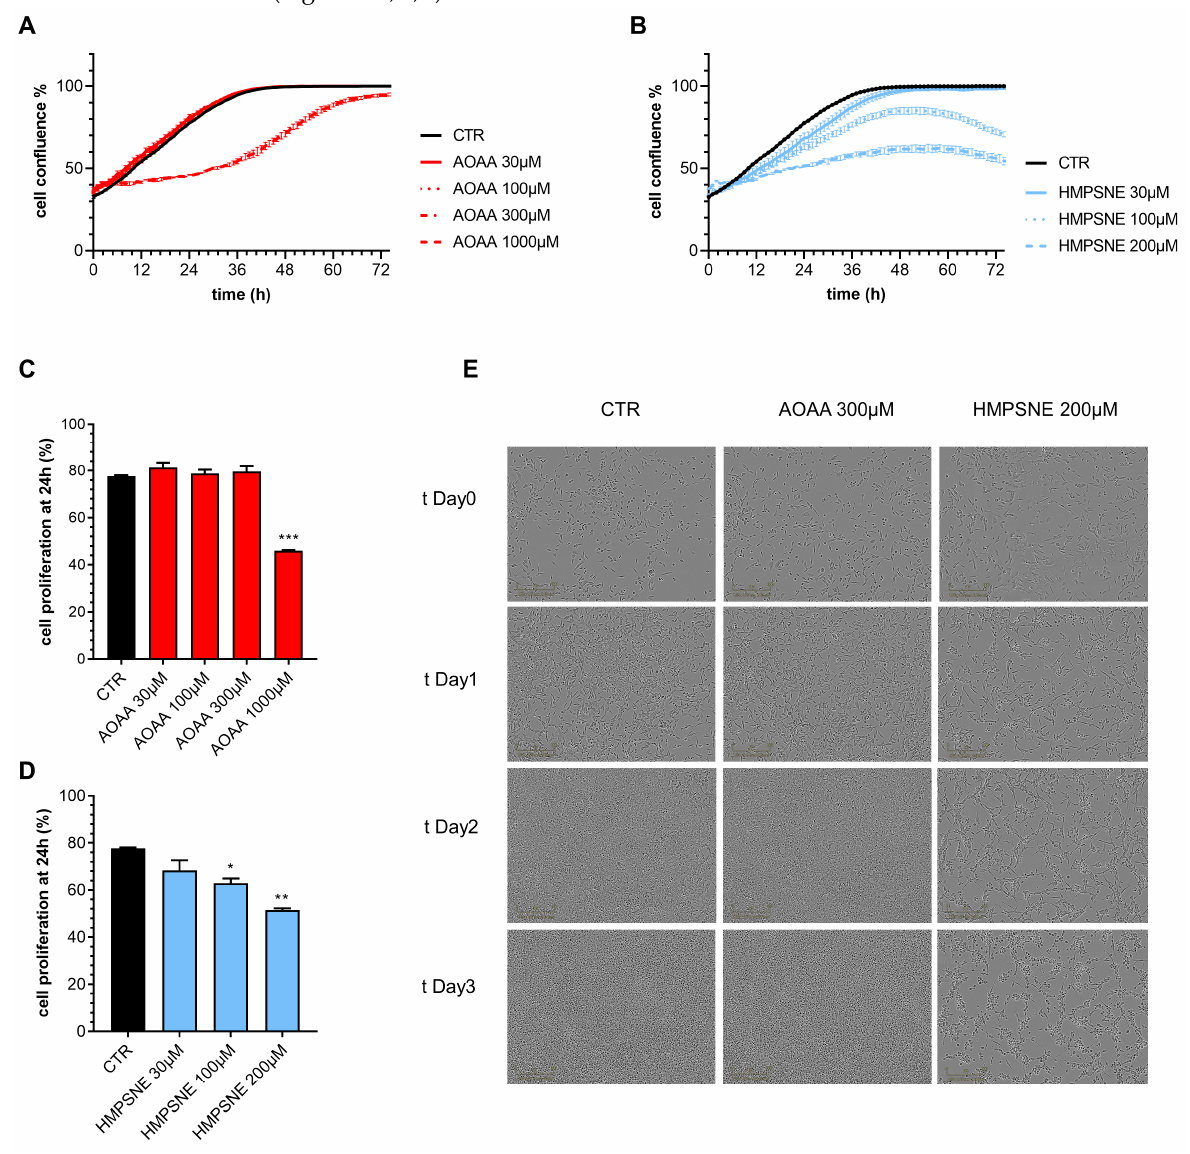
Figure 6. Effect of inhibition of H 2 S biosynthesis on EO771 cell proliferation. ( A , B ): Proliferation curves of E0771 cells treated with AOAA ( A ) or HMPSNE ( B ). Cells were monitored over 72 h. Quantification of cell confluence reached after 24 h of E0771 cells treated with AOAA ( C ) or HMSNE ( D ). Representative images of 3 days treatment obtained with IncuCyte ZOOM € . N = 3 independent experiments ± SEM; * p < 0.05, ** p < 0.01 and *** p < 0.001 show a significant inhibitory effect of AOAA or HMPSNE.